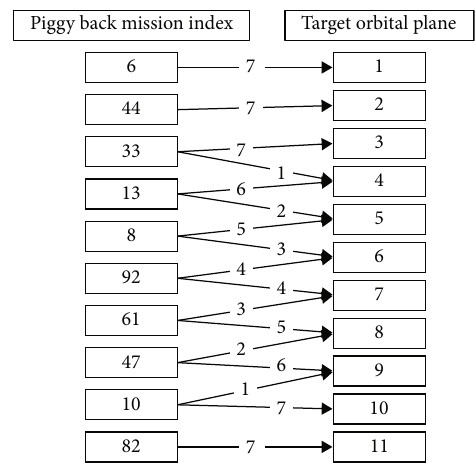
Figure 16: The cross-plane deployment